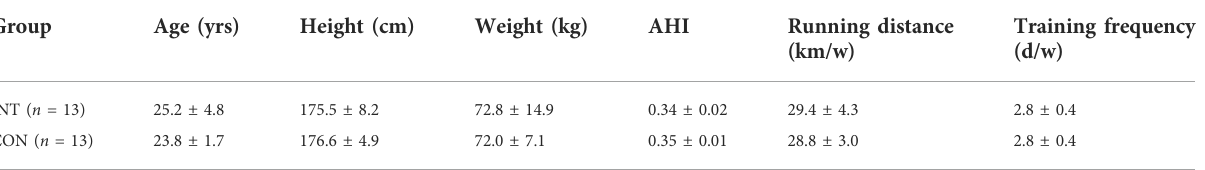
TABLE 3 The basic information of participants.